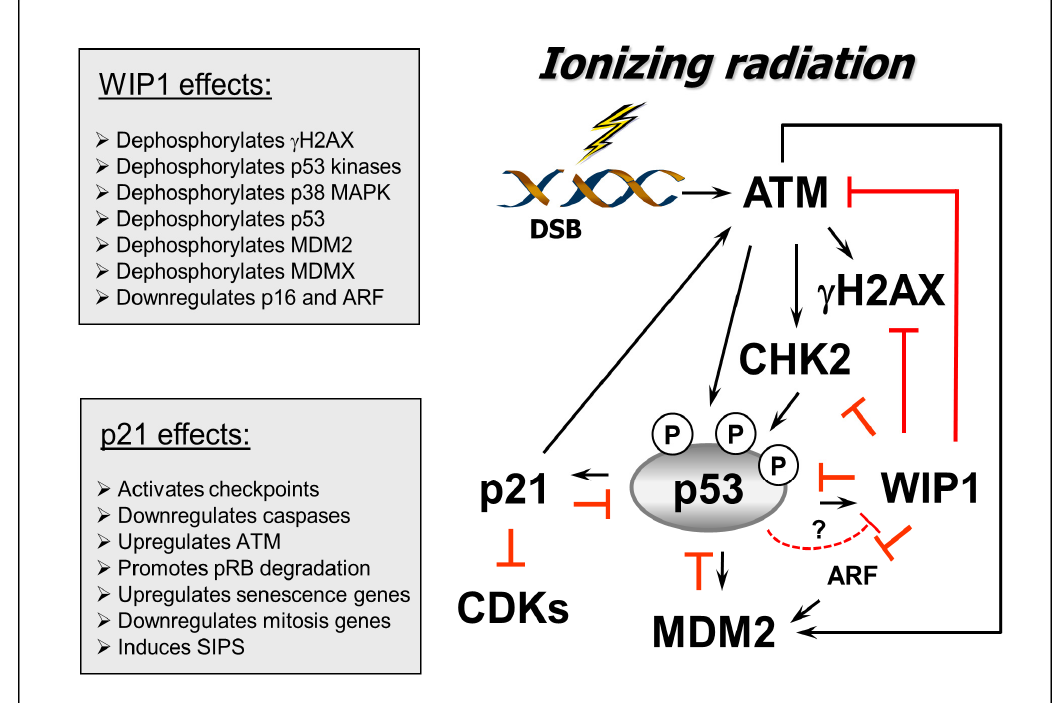
Figure 2. A schematic of the p53-MDM2, p53-WIP1, and p53-p21 regulatory loops discussed in this article. Arrows indicate stimulation and T-shaped lines indicate inhibition. Multiple functions of WIP1 and p21 in the DNA damage response are